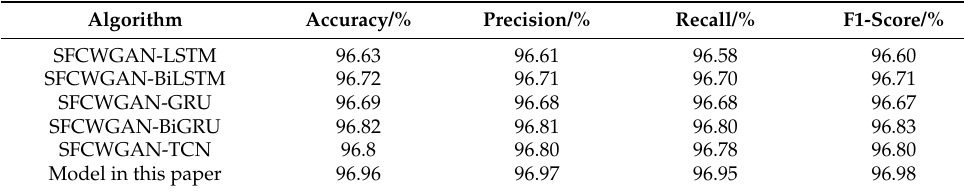
Table 10. Detection accuracy under the influence of difference algorithms on DataCon